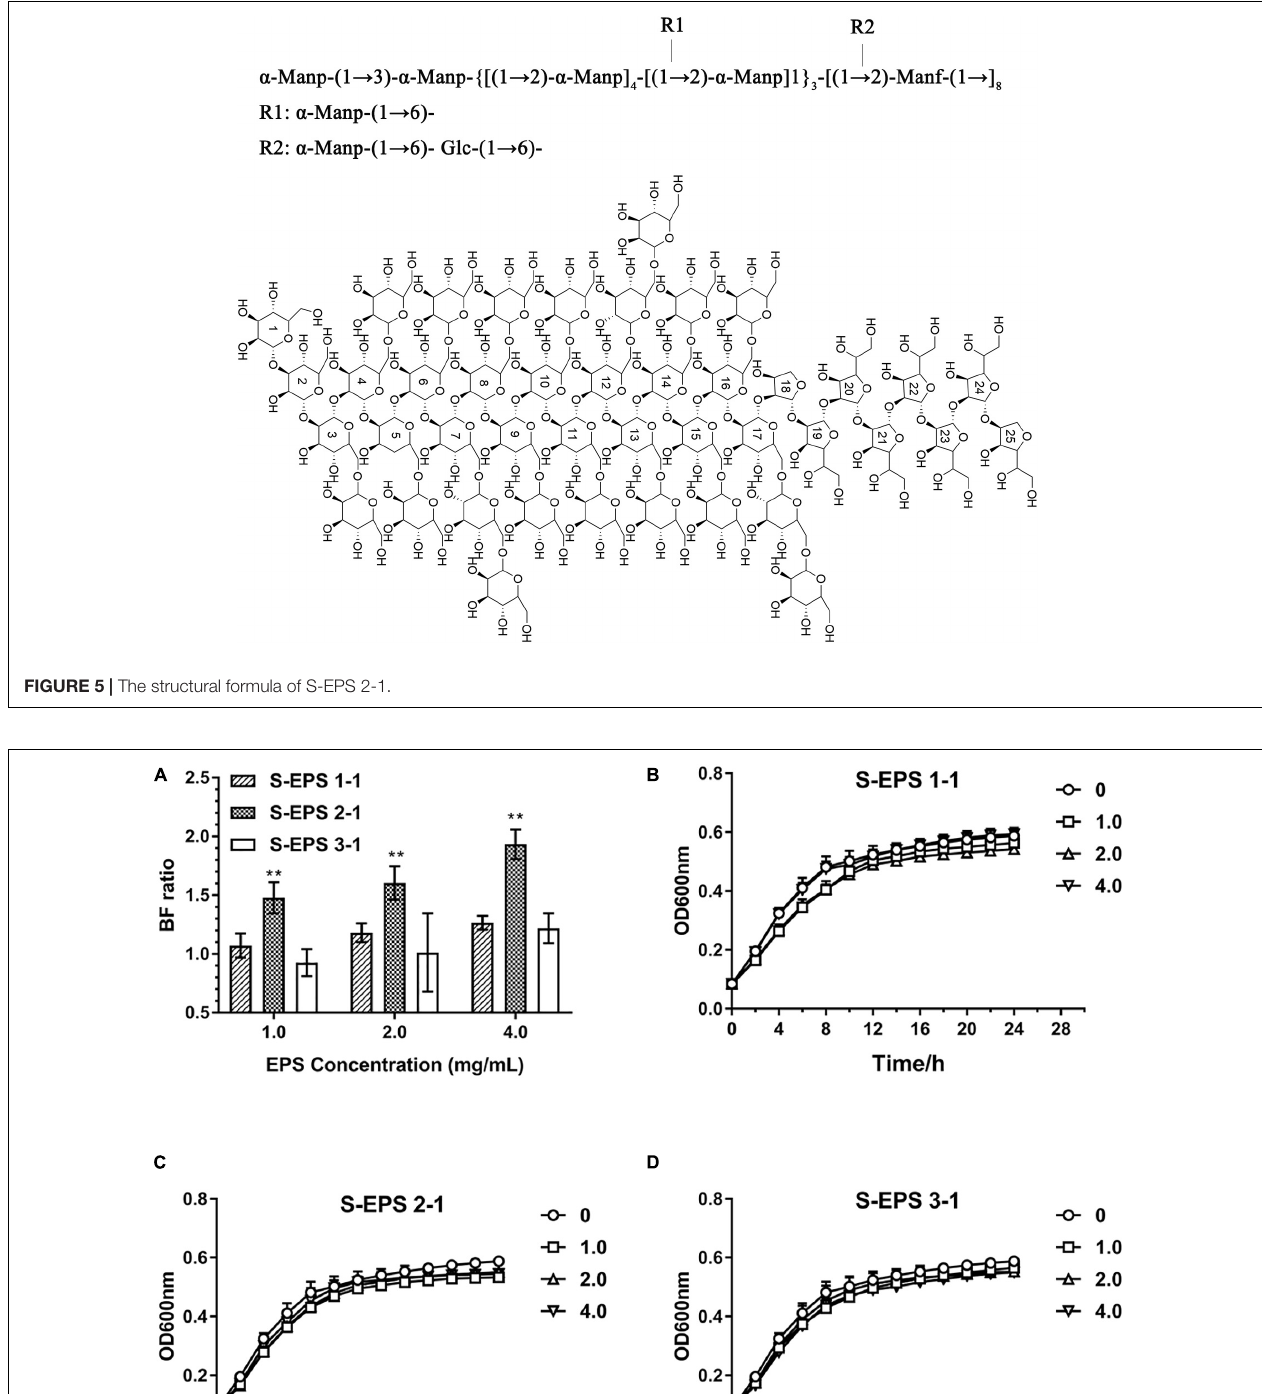
Frontiers in Microbiology |